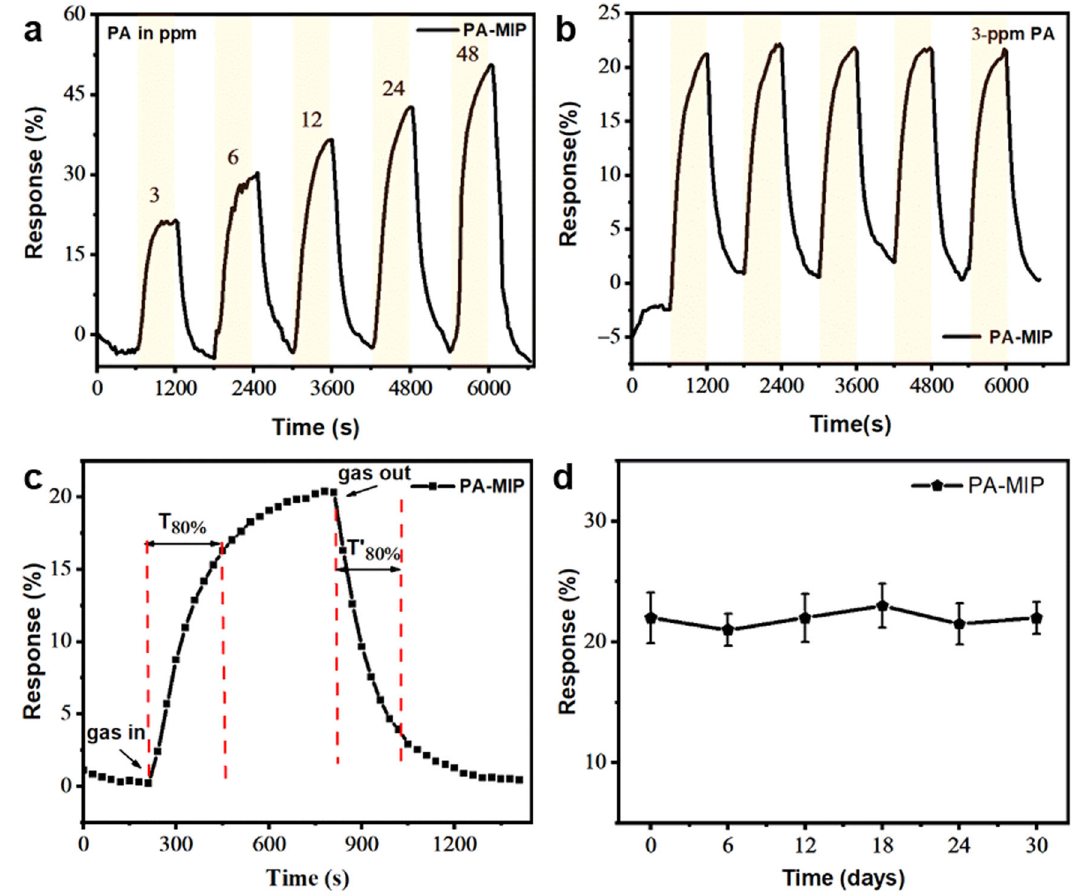
Fig. 6 Response characteristics of sensor unit coated with PA-MIP. a Real-time sensing response of sensor unit coated with PA-MIP to PA vapor exposures at concentrations ranging from 3 to 48 ppm. b Cycling performance of sensor unit coated with PA-MIP in response to PA vapor at 3 ppm level. c Response and recovery times calculated for 3 ppm of PA. d Long-term response stability over one month to 3 ppm of PA for sensor unit coated with